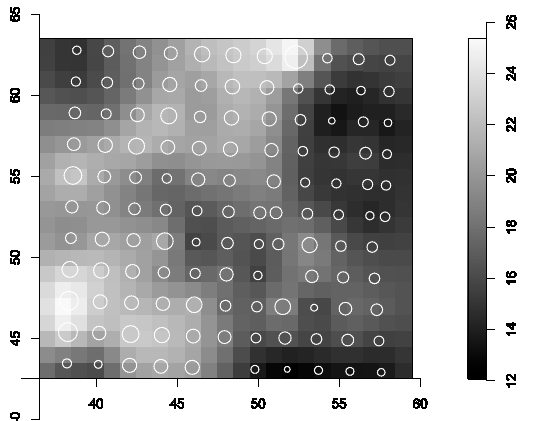
Figure 2. Light environment in the regeneration subplot. Colors correspond to percent of open area radiation from analyzing hemispherical photographs taken in a 2 m × 2 m grid.